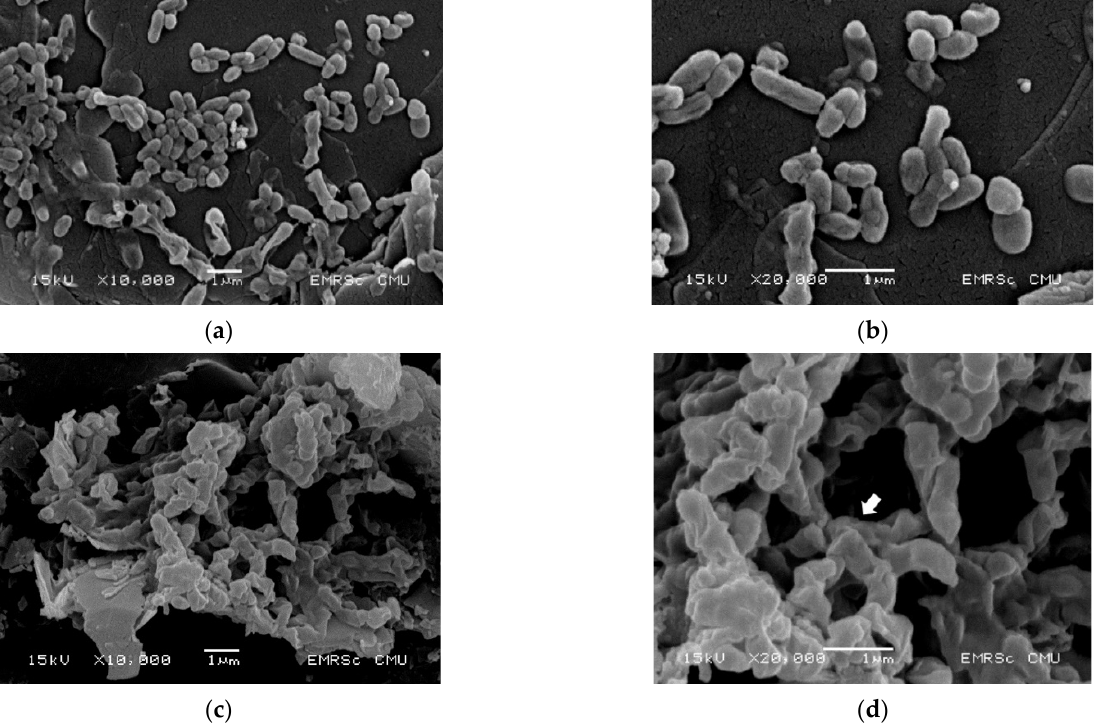
Figure 3. Effect of EGCG on bacterial cell morphology. V. cholerae N16961 was treated for 2 h at 37 °C with EGCG 0.5 mg/mL. Scanning electron microscopy (SEM) images at ×10,000 and ×20,000 magnifications were demonstrated: ( a , b ) are the controls, ( c , d ) are the effective treatments. The cell membrane disruption is represented by the arrow.